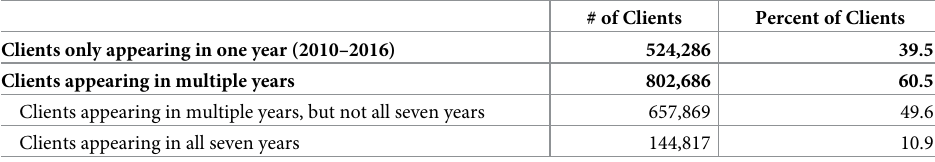
Table 2. RSR overall linkage rate